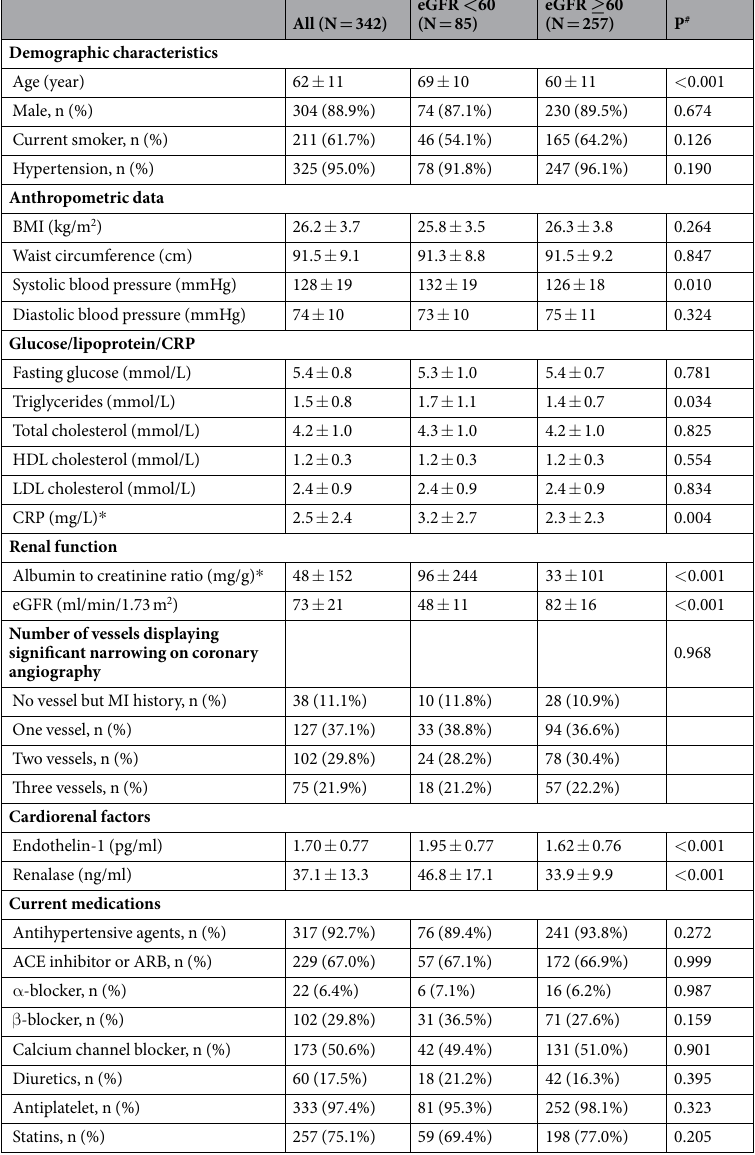
Table 1. Clinical characteristics of patients stratified by an estimated glomerular filtration rate (eGFR) of 60 ml/ min/1.73 m 2 . ACE = angiotensin-converting enzyme, ARB = angiotensin II receptor blocker, BMI = body mass index, CRP = C-reactive protein, eGFR = estimated glomerular filtration rate, HDL = high-density lipoprotein, LDL = low-density lipoprotein, MI = myocardial infarction. * Values were logarithm-transformed (log) in the analyses due to a skewed distribution. # P values for differences between the two